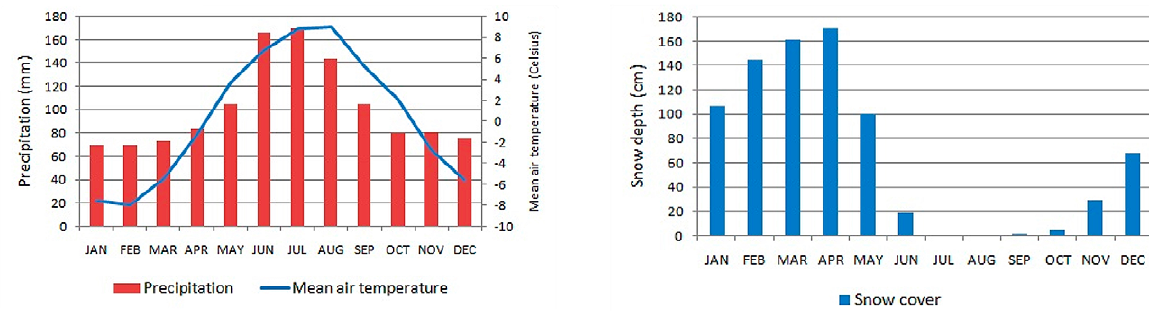
Figure 1. Temperature, precipitation and snow cover at Bâlea Lake Weather Station